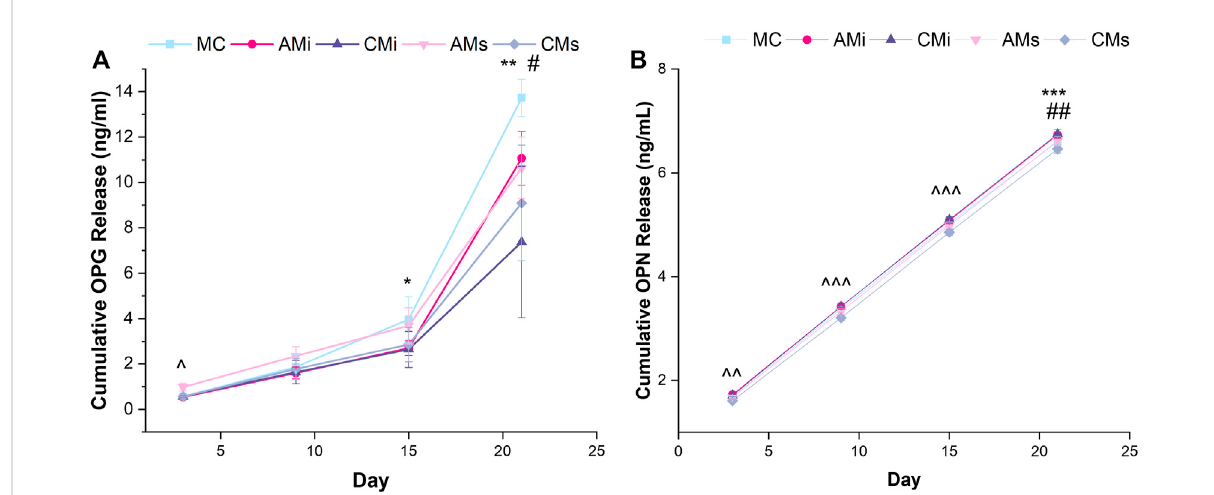
FIGURE 4 Osteoprotegerin (OPG) and osteopontin (OPN) cumulative release from hMSC-seededmineralized collagen scaffolds(MC) containing amnion or chorion particles (AMi or CMi) or amnion or chorion extracts (AMs or CMs) measured using ELISAs. (A) Mesenchymal stem cells produce OPG to inhibit osteoclastogenesis.* denotes that MC has signi fi cantly ( p < 0.05) greater release of OPG than CMi, ** denotes that MC has signi fi cantly ( p < 0.05)greaterreleaseofOPGthanbothchorionscaffoldvariants, ^ denotesthatAMsissigni fi cantly( p < 0.05)greaterthanallothergroups,and# denotes that AMi releases signi fi cantly greater OPG than CMs. (B) Osteopontin (OPN) is an indication of mesenchymal stem cell